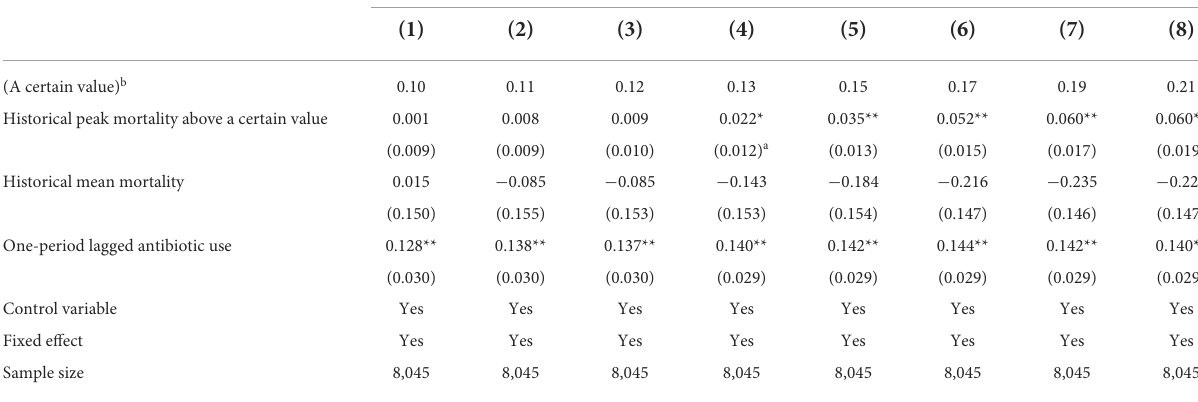
TABLE 3 Threshold effect of historical peak mortality on current antibiotic use.